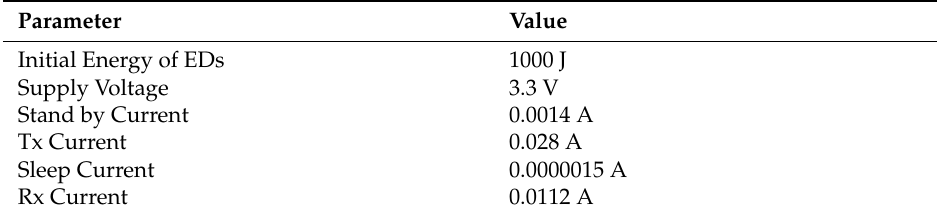
Table 2. Energy model parameters.